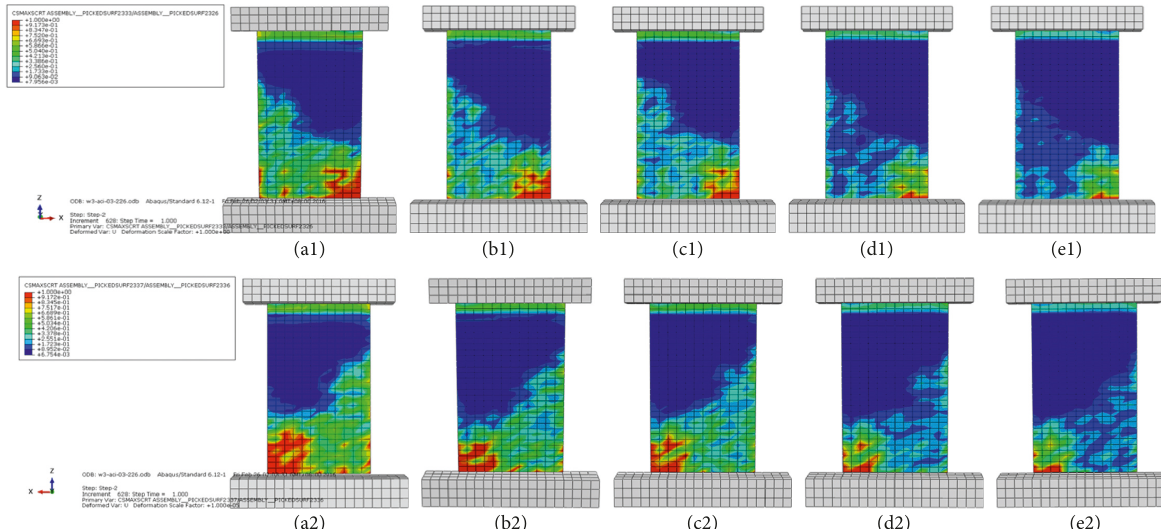
Figure 21: Maximum traction damage initiation criterion index CSMAXSCR of W3 under 0.3 axial compression ratio.